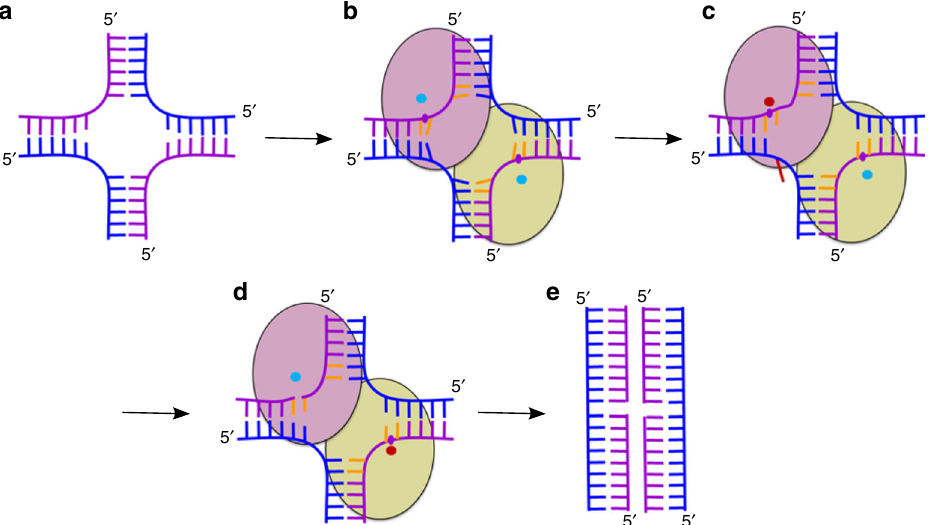
Fig. 6 Cartoon representation of the mechanism of HJ resolution by RuvC. a Holliday junction. Cleaved and non-cleaved DNA strands are shown in purple and blue ladder-like representations, respectively. b Binding of the HJ DNA. The subunits of the dimer are shown as yellow green and pink ovals. The scissile phosphate is marked as a purple circle. Cyan circles show active sites in an inactive con fi guration. c Flipping of the adenine (red) opposite the scissile base. The active site in the catalytic con fi guration is shown as a red circle. d The second cut. e Resolution